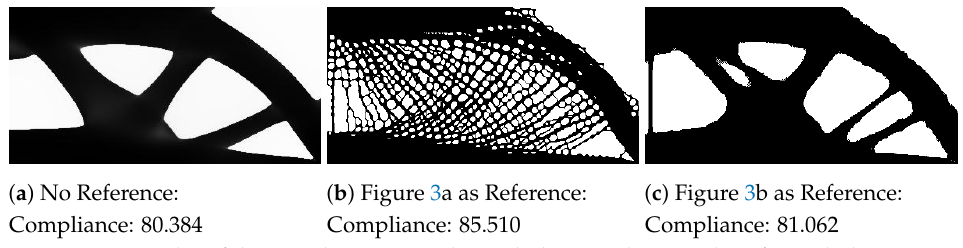
Figure 5. Examples of the MBB beam examples with the compliance values for each